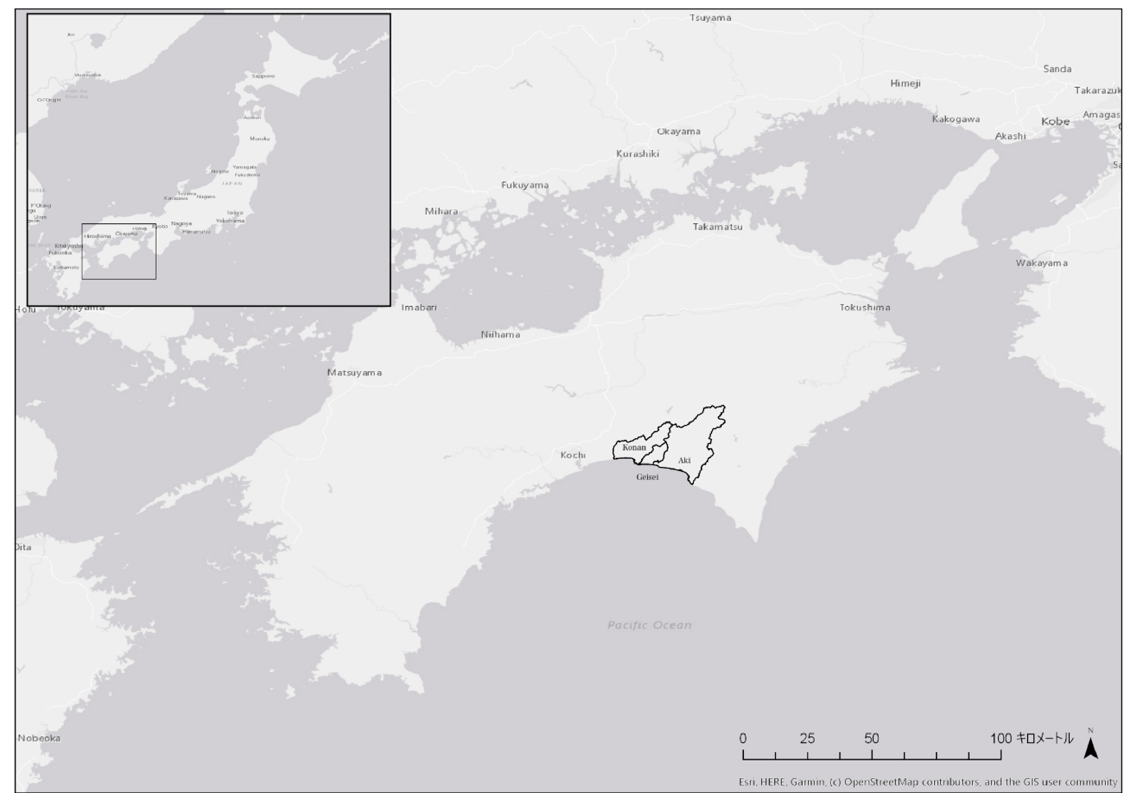
Figure 1. Locations of the cities of Konan and Aki, and the village of Geisei in the Shikoku region of Japan. キロメートル : km. An earthquake along the Nankai Trough is expected to occur within the next 30 years, and tsunamis are predicted to occur along the Pacific coast as a result [29]. A 30-cm tsu- nami is expected to reach Aki first, within 5 min of the earthquake. It is expected to arrive in Geisei within 5 to 10 min and to reach Konan within 10 to 20 min [30].